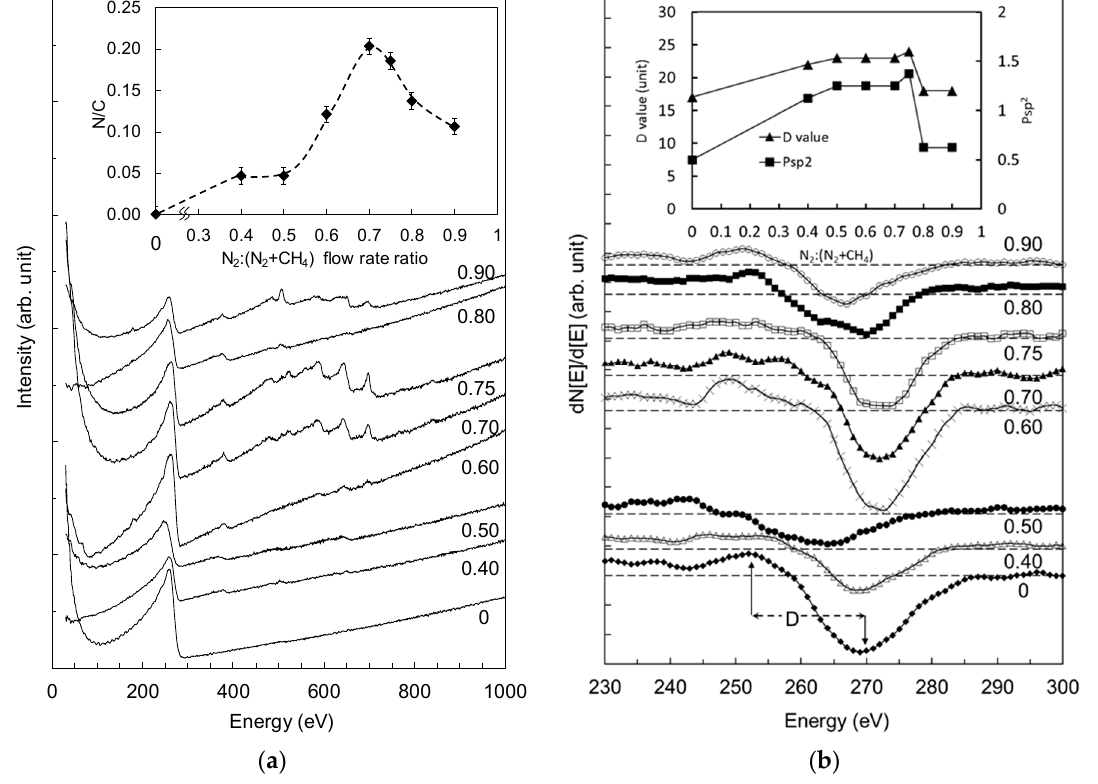
Figure 4. The ( a ) Auger electron spectroscopy (AES) and ( b ) KLL first derivative spectra of films deposited at different N 2 :(N 2 + CH 4 ) ratios. The inset in ( a ) is the variation of N/C ratio, and the inset in ( b ) is the variation of D values with N 2 :(N 2 + CH 4 ) ratio.